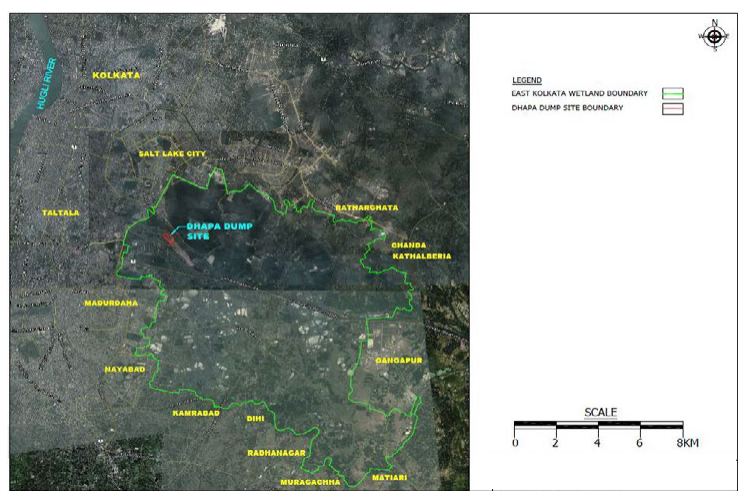
Fig. 2: Airborne view of landfill site as a part of East Kolkata Wetlands